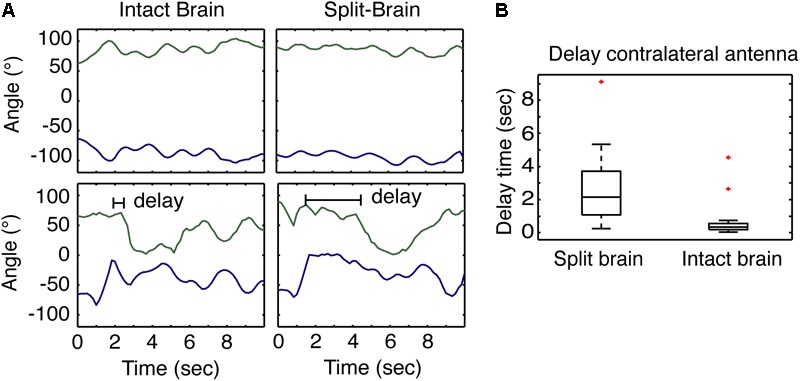
Antennae response to odors in split- and intact brain cockroaches. (A) Example of the at rest movement of the antennae of a restrained cockroach (top) compared to the response of both antennae of a restrained cockroach following odor stimulation displaced 45° to one side. (B) The response of the contralateral antennae in split-brain cockroaches (n = 24) was significantly delayed compared to the response of intact brain cockroaches (n = 30) (F = 5.18, P = 5.08E-5; z = 5.09; P = 3.48E-7).